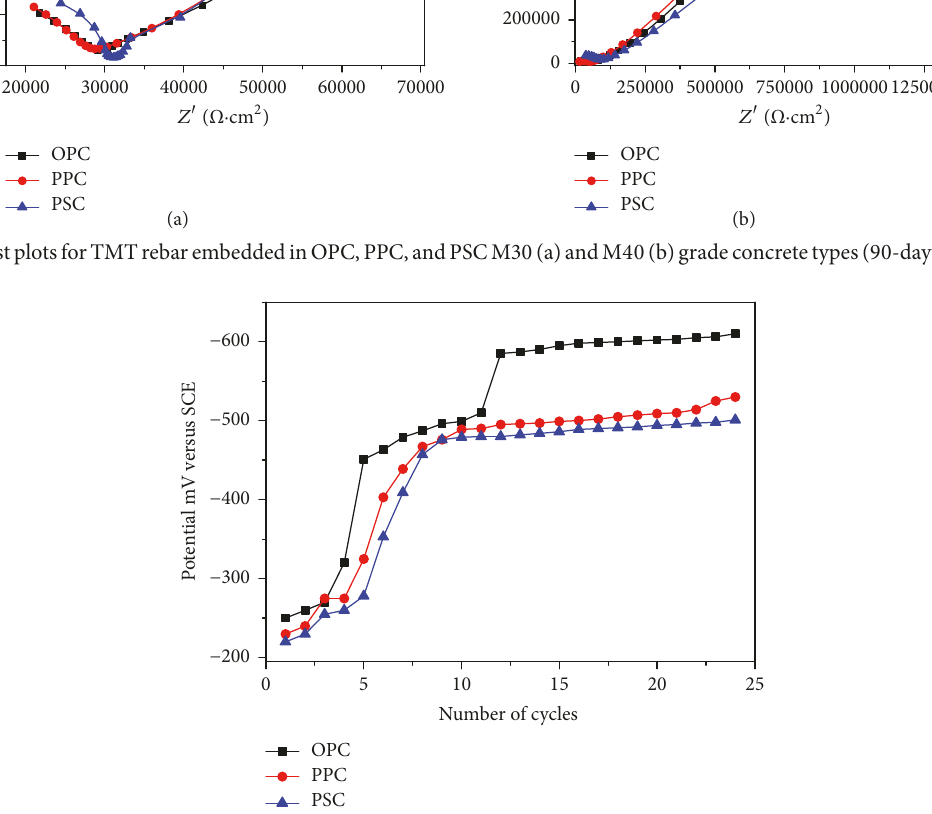
Figure 10: Potential versus number of cycles of exposure for rebar in OPC, PPC, and PSC M30 grade concrete types (90-day cured specimens) under macrocell condition.